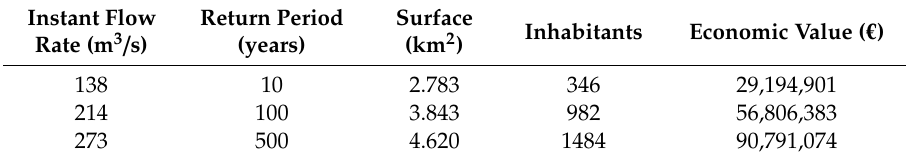
Table 1. Instant (15 minute) flow rate, flood surface, inhabitants potentially affected and economic damage 1 .